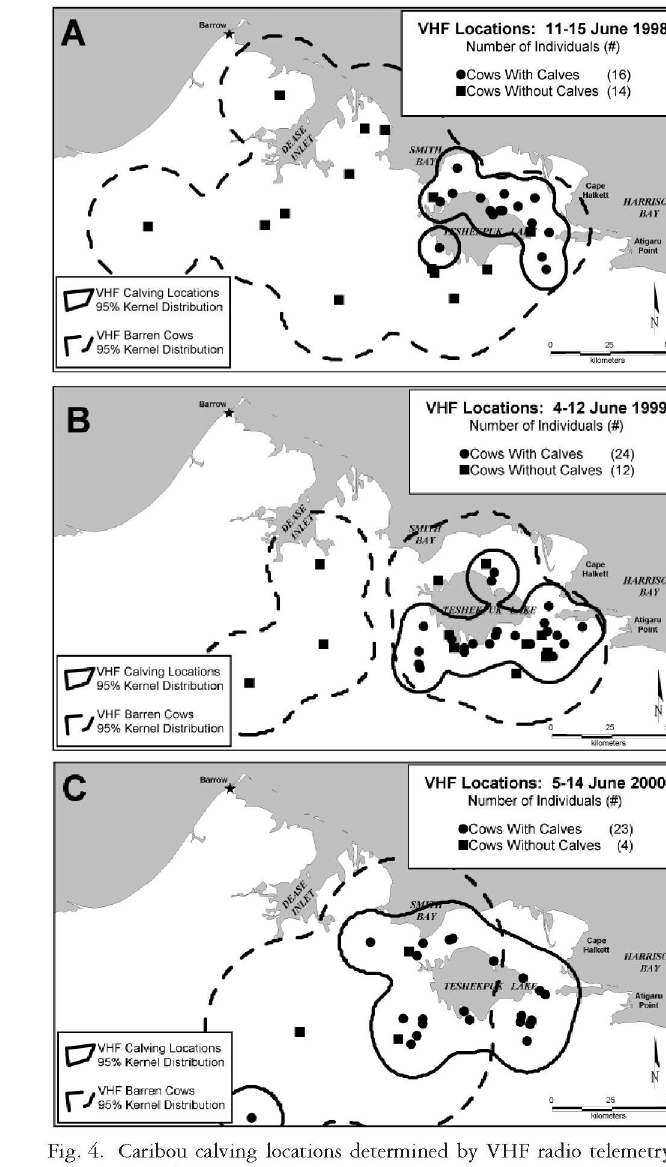
Fig. 4. Caribou calving locations determined by VHF radio telemetry from 4—15 June 1998—2000 (Carroll, 2001) and fixed kernel utilization distributions for calving locations and for cows with¬ out calves in the National Petroleum Reserve—Alaska. west of the lake. Cow caribou MCP ranges between 1—20 June (28—58 locations per cow, n=6 cows) were similar for cow/calf pairs (621 ± 524.3 km 2 , n=4 cows) and cows without calves (468 ± 303.3 km 2 , n=2 cows). MCP ranges for satellite-collared cows during our 4—12 June survey period (6—22 locations per cow, n=6 cows) were smaller and less variable for cow/calf pairs (15 ± 6.6 km 2 , n=4 cows) than for cows without calves (87 ± 72.3 km 2 , n=2),